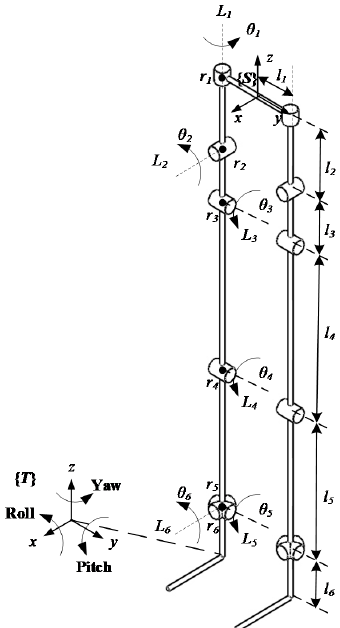
Figure 7. Coordinate system of the right leg of biped robot.